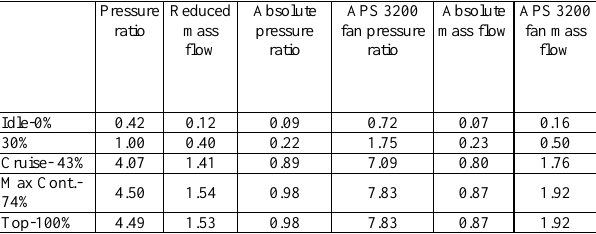
Table 19. Parameter of APS 3200 V = 0 Ma, H = 7000 m